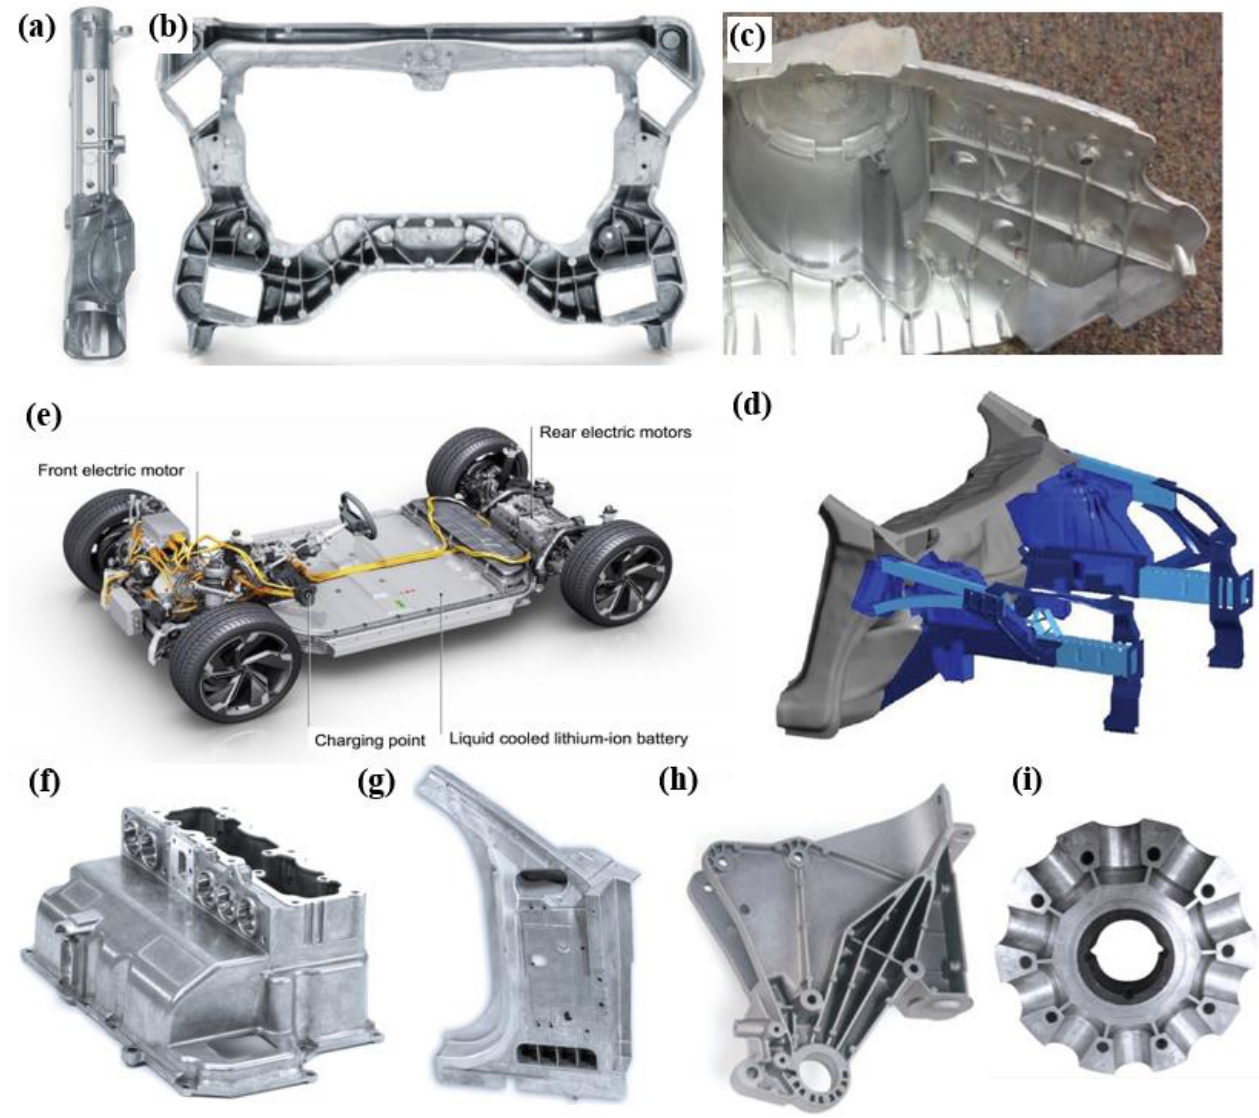
Figure 2. Automotive applications for Al-Si alloys, such as ( a ) steering column, ( b ) engine cradle [40], ( c ) shock tower [2], ( d ) front section [52], ( e ) Li-ion battery compartment for Audi e-tron [45], ( f ) upper safety housing for high-voltage heat plug connectors, ( g ) A-pillar, ( h ) truck cab tilting joint, and ( i ) ventilator hub [40]. Reproduced with permission from Elsevier and open-access websites.